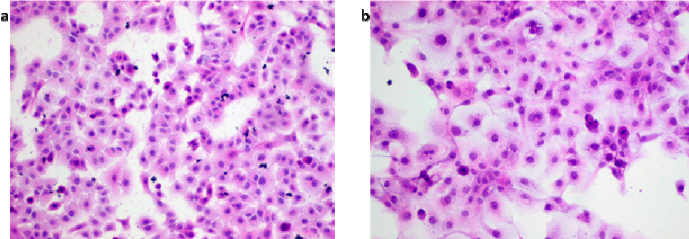
Figure 7. Hematoxylin–eosin (H–E) staining for laryngeal cancer cell lines RK33 ( a ) and RK45 ( b ). Table 1. The percentage of cancer cells positive for active caspase-3 when treated with IMP for 48h. ctr ctr+ 10 µM 25 µM 50 µM 100 µM RK33 0.3100 24.51 0.2600 0.7533 0.8400 2.033 RK45 1.190 25.12 1.000 1.090 1.157 1.870 TE671 1.067 38.61 17.83